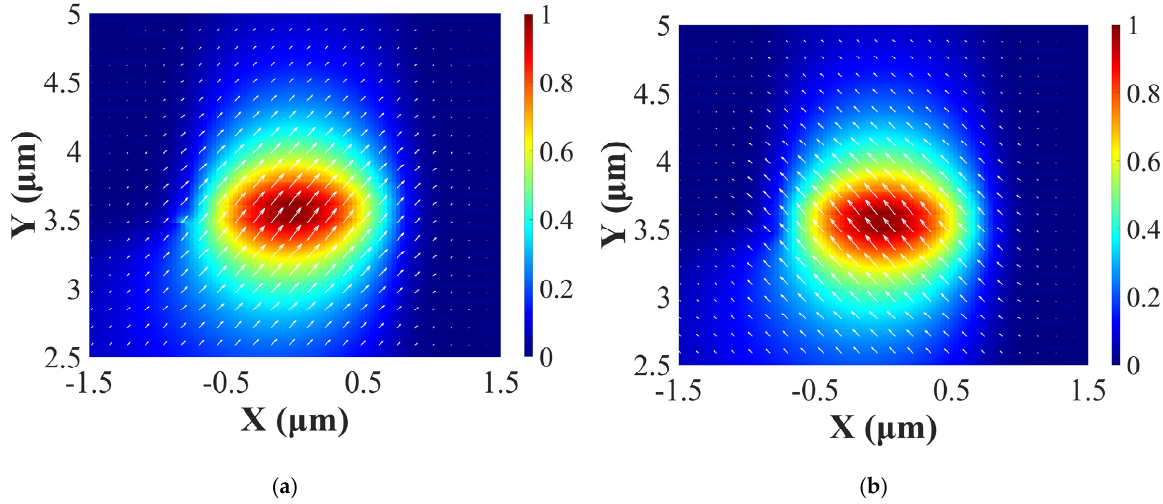
Figure 6. Periodic PCE curves of the three profiles.